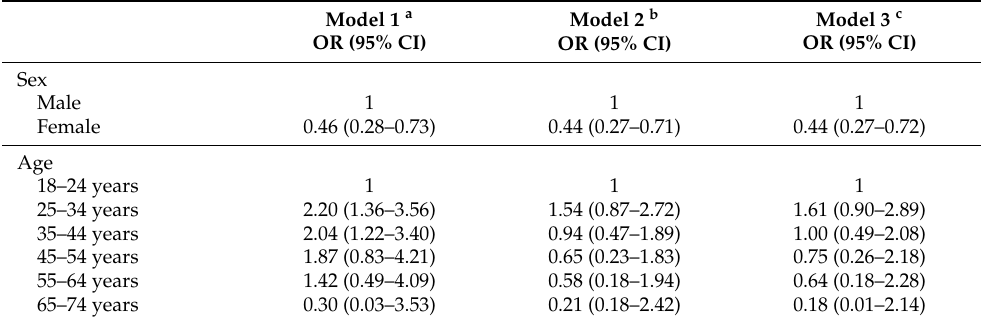
Table 3. Adjusted odds ratios (95% confidence interval) for prevalence of weekly sexual activity in relation to sex and age subgroups (references male and 18–24 years subgroups